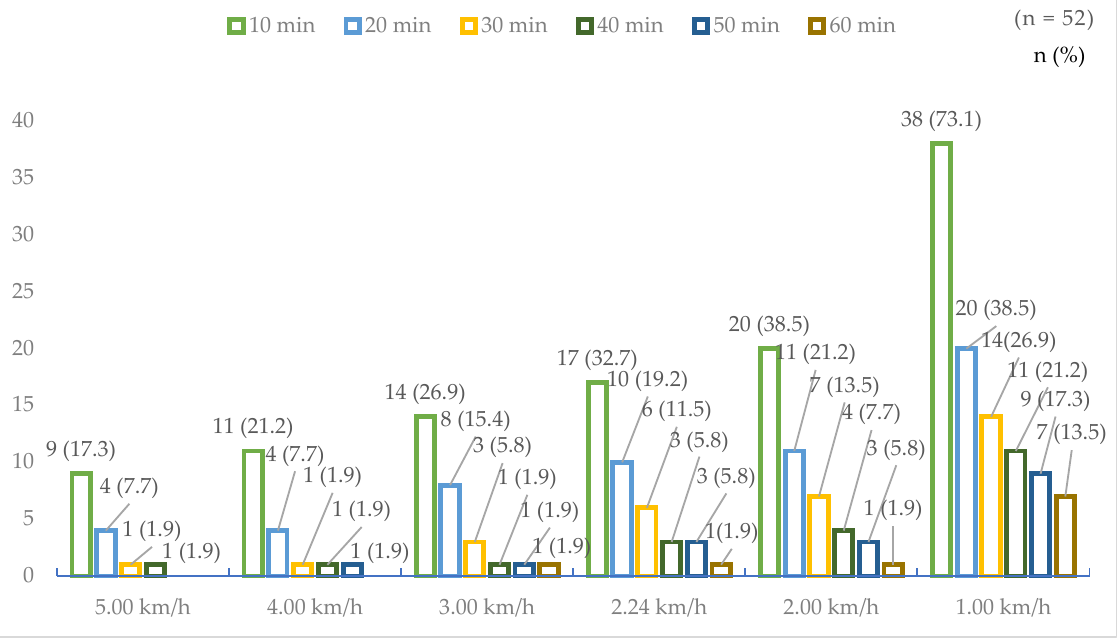
Figure 7. Number of late evacuations by walking speed for each tsunami arrival time.